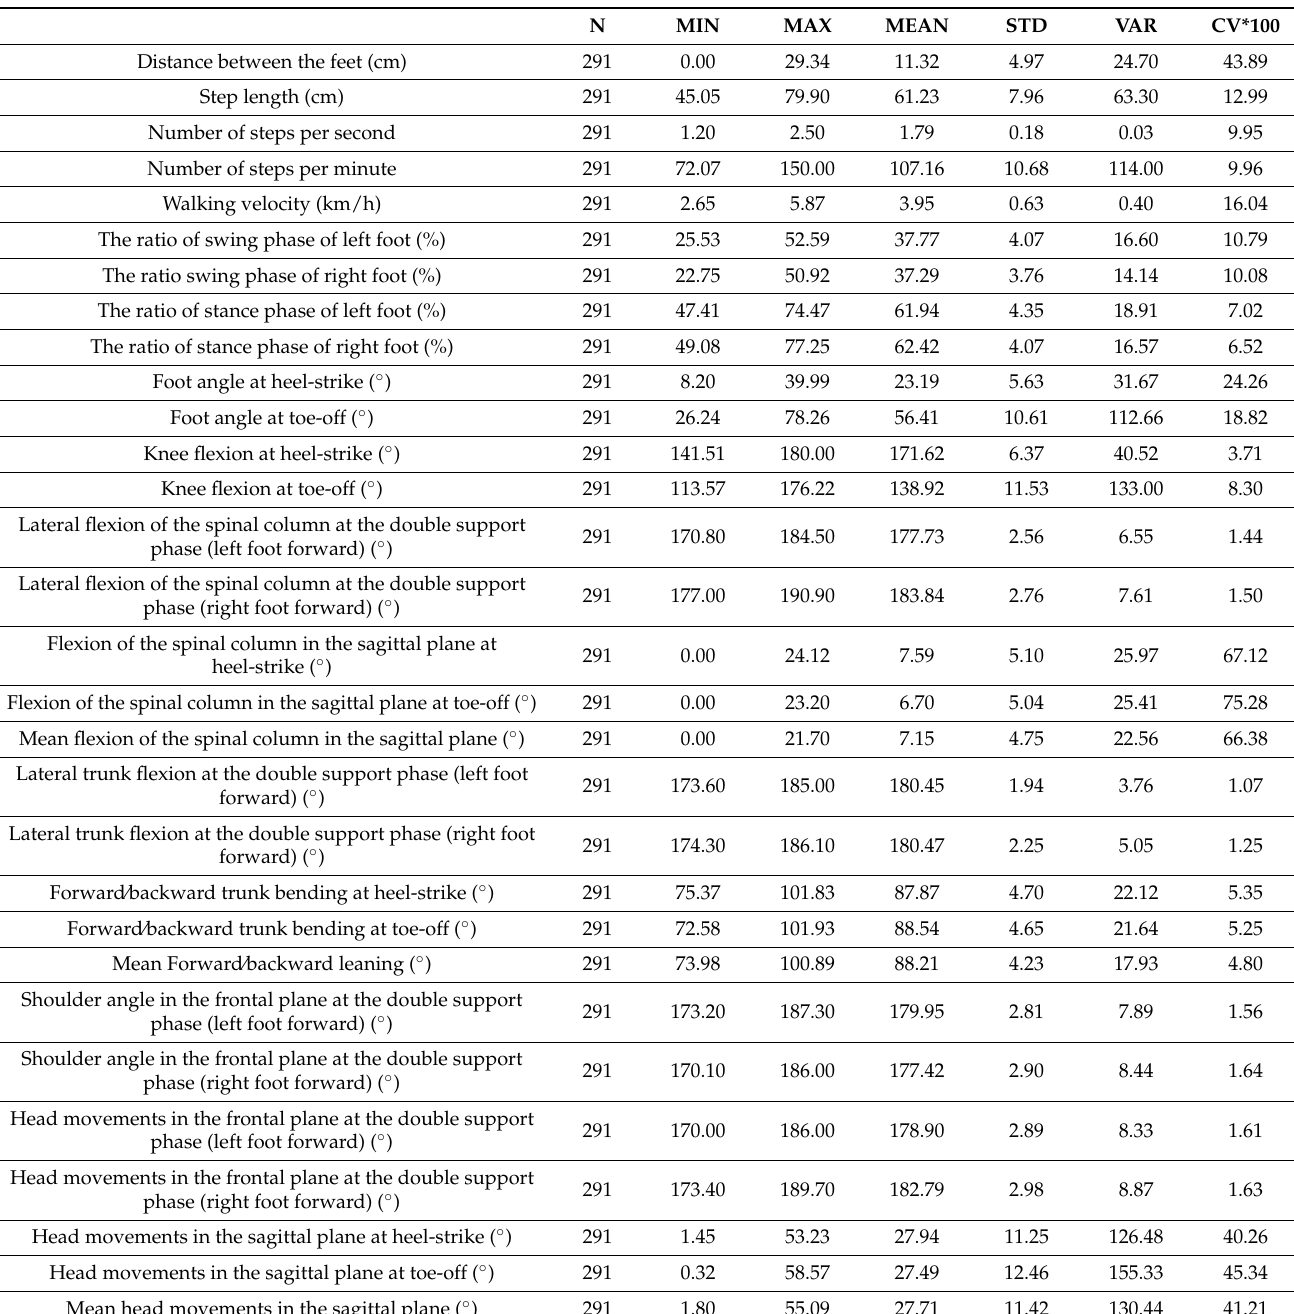
Table 5. Descriptive statistics for each